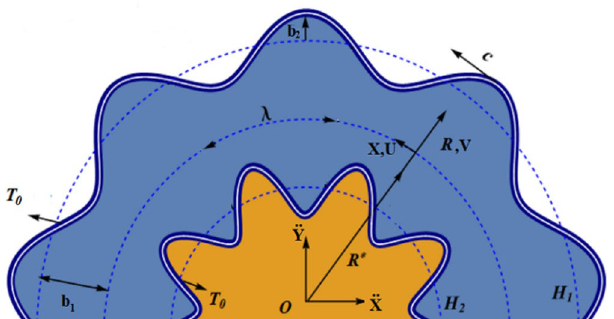
Figure 1. Geometrical interpretation of a symmetrical curved